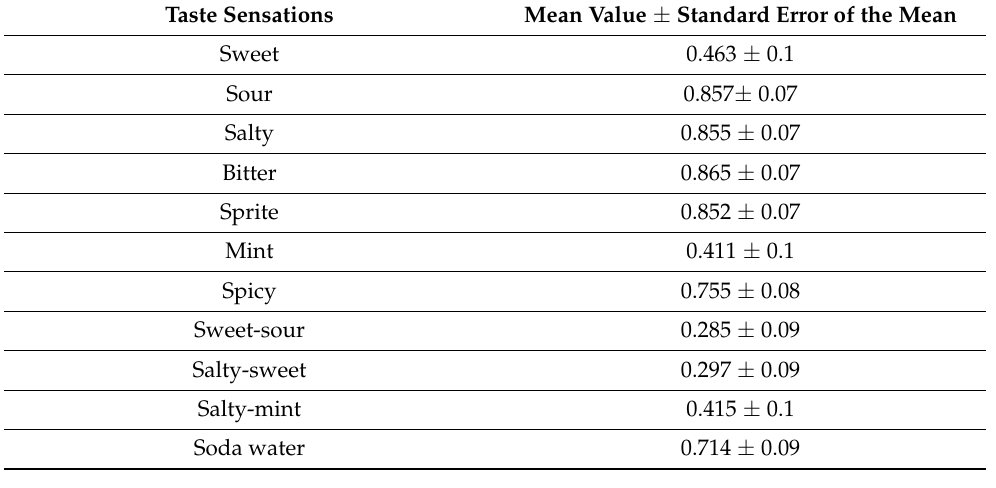
Figure 5. Different taste sensations and flavors versus mean value of sensation (%). Table 3. The mean value of taste sensations and standard error of the mean of 23 participants.